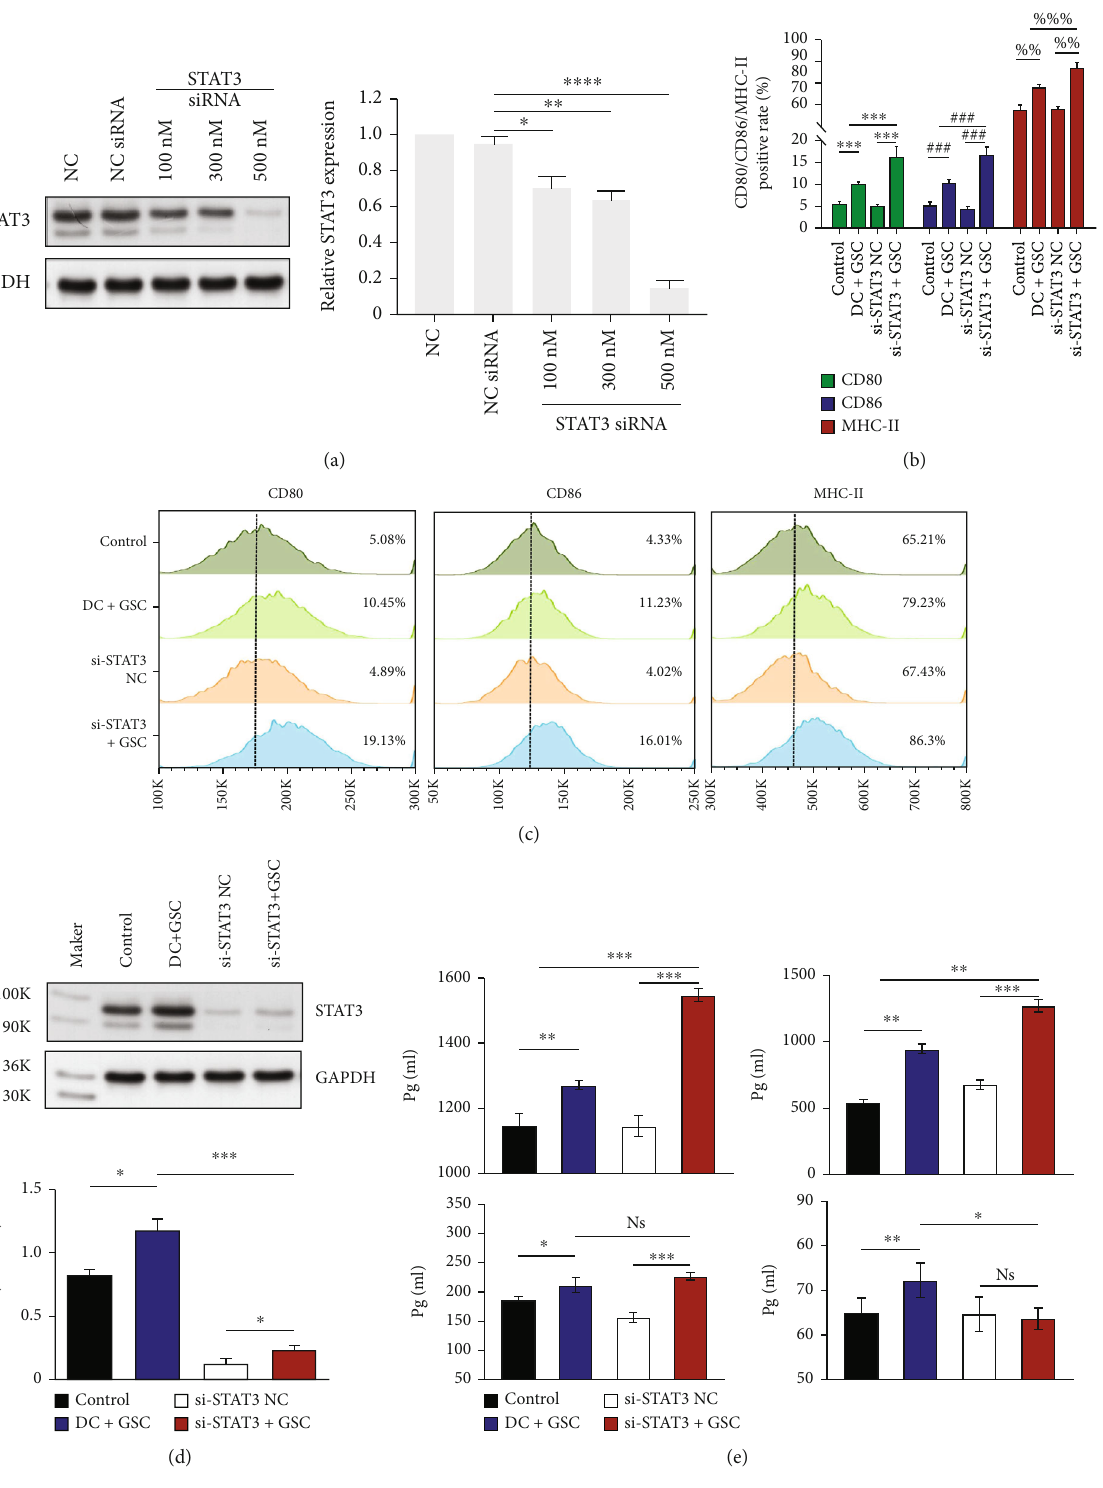
Figure 4: The expressions of DC cell surface molecules (CD80, CD86, and MHC-II) as determined by fl ow cytometric analysis. (a) DCs were transfected with 500nM nonspeci fi c siRNA (NC-siRNA) or 100nM, 300nM, or 500 nM siRNA targeted against STAT3 (STAT3 siRNA). (b and c) Flow cytometry analysis of changes in the expression of costimulatory molecules and mature molecules on the cell surface of di ff erent DC groups. (d) The expression of STAT3 in each DC groups by Western blotting. (e) The cytokine secretion levels of IL-12, IL-6, TNF- α , and IL-10 in the supernatants were measured in the four groups by ELISA. The levels of IL-12 and IL-6 were signi fi cantly increased in the si-STAT3+GSC group compared with the DC+GSC group, and the level of IL-10 showed the opposite trend. Molecular weight: STAT3(88 kDa) and GAPDH(36kD). ∗ p < 0 : 05 , ∗∗ p < 0 : 01 , ∗∗∗ p < 0 : 001